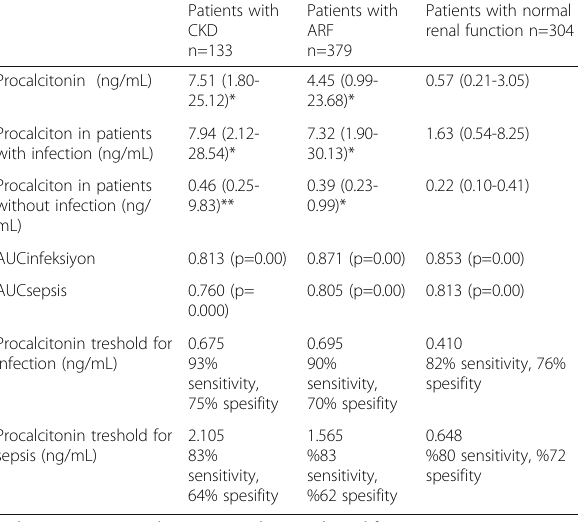
Table 1 (abstract 001057). Procalcitonin values based on renal function and infection